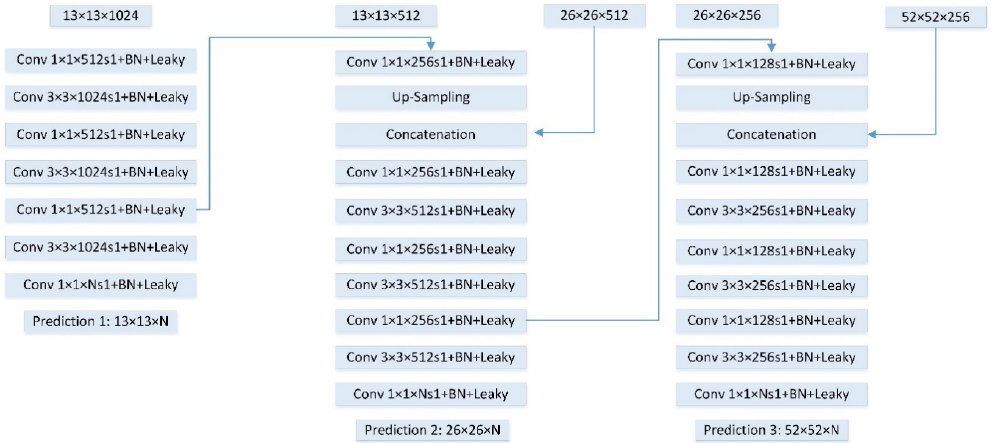
Figure 5. Multi-scale feature fusion module. Feature maps from different layers are merged through up-sampling and concatenation operations, which then predict object detections. Each convolutional layer is followed with a batch normalization (BN) layer and a Leaky ReLU layer. The stride of convolution is 1 (s1).